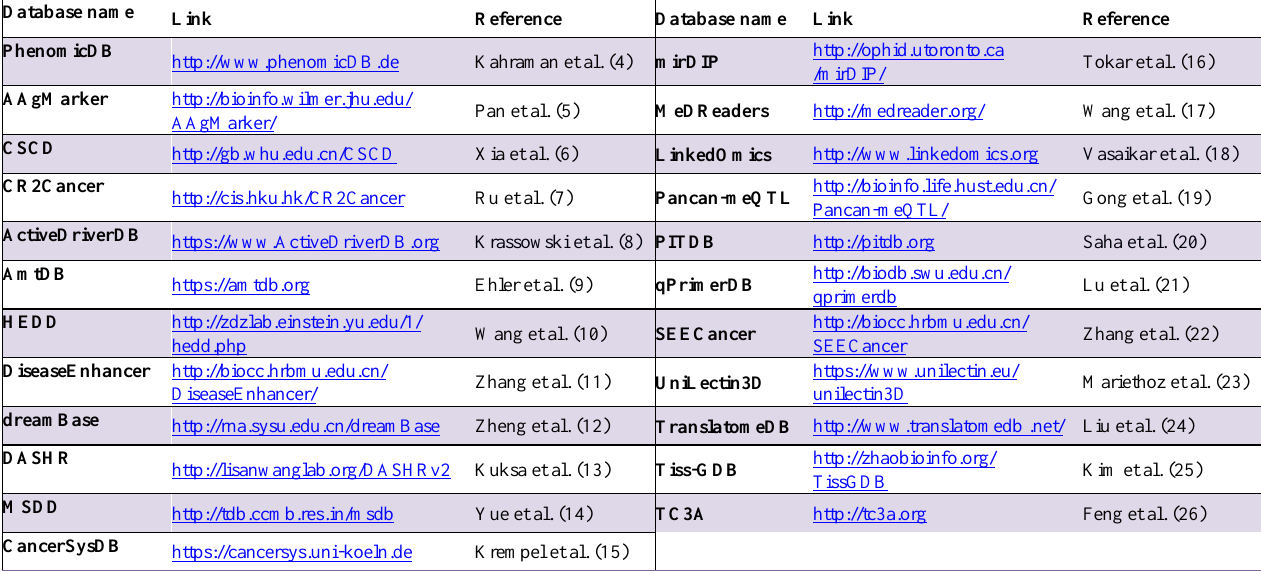
Table 1. List of some recently published